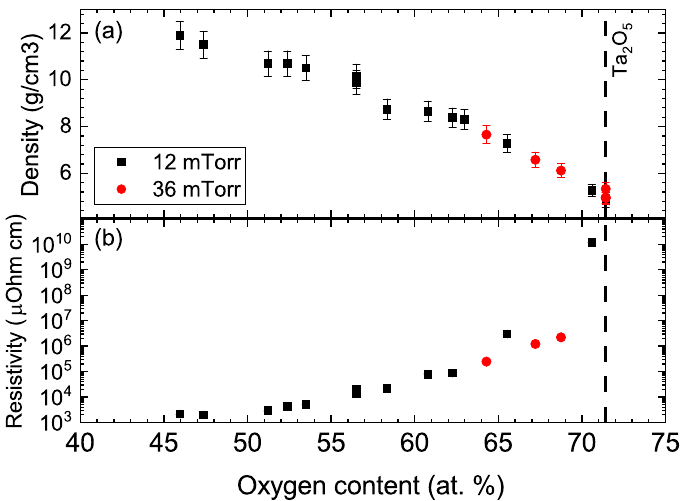
Figure 4. Oxygen content dependence of ( a ) mass density and ( b ) room-temperature electrical resistivity for TaO x films, showing how increasing presence of the less-dense Ta 2 O 5 phase leads to a decrease in mass density and an increase in electrical resistivity over seven orders of magnitude. The vertical dashed line corresponds to stoichiometric Ta 2 O 5 (with 71.4 at.% of O), marked by a dramatic increase in resistivity. The resistivity of stoichiometric Ta 2 O 5 films was too high to be measured with the methods employed in this study. Error bars arise from uncertainty in areal density as determined by RBS and scatter in resistance measurements (however, in this case, the error bars are smaller than the